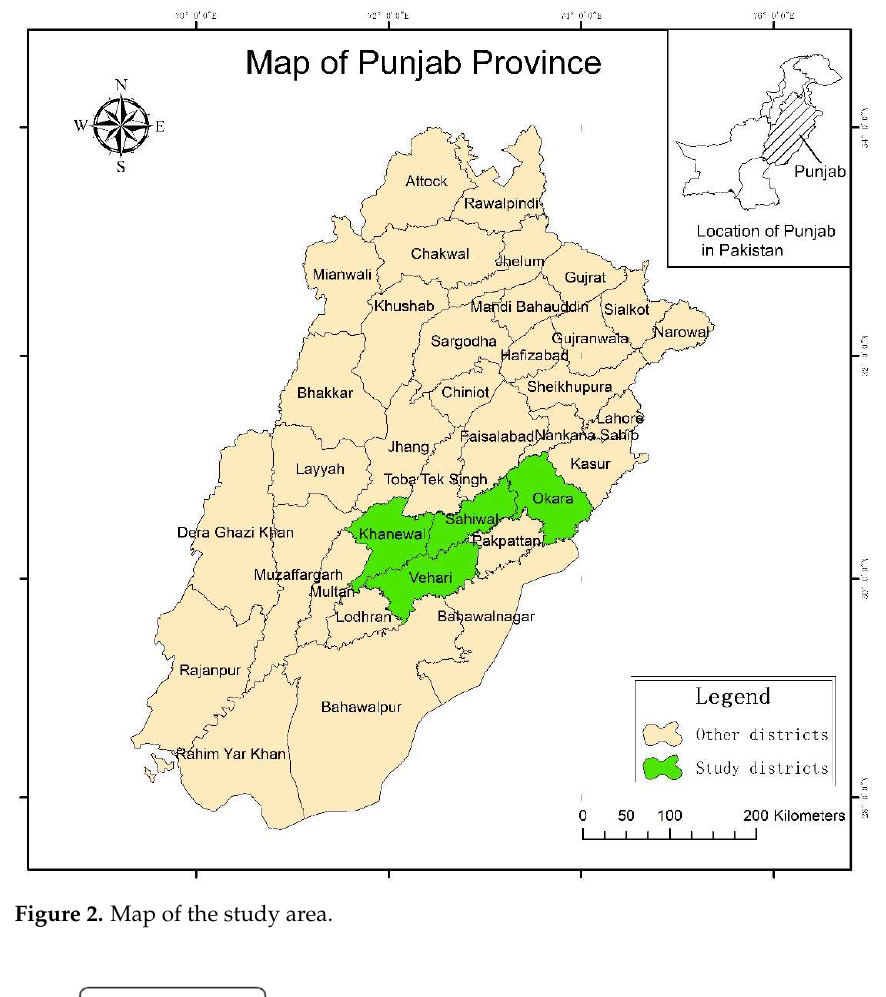
Agronomy 2022 , 12 , x FOR PEER REVIEW Figure 2. Map of the study area. Figure 2. Map the study area.